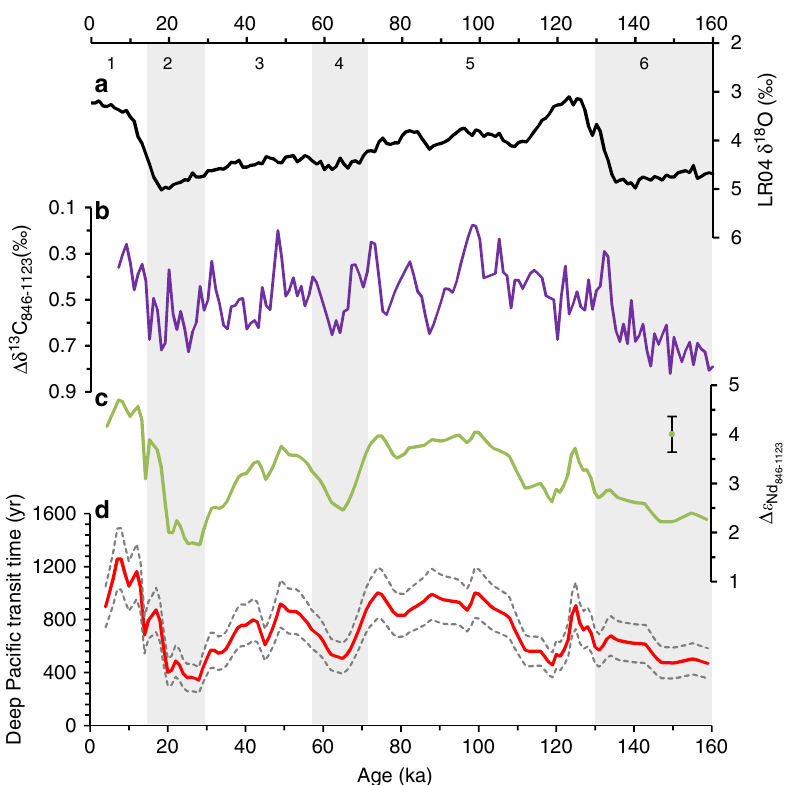
Fig. 7 Deep Paci fi c transit time over the last 160 ka. a Benthic δ 18 O stack 50 . b Benthic δ 13 C gradients between ODP846 and ODP1123. Note that the benthic δ 13 C of ODP846 ( C . wuellerstor fi ) 70 and ODP1123 ( Uvigerina spp.) 8 are measured on different species and vital effects might affect their δ 13 C signatures. c Foraminiferal ε Nd gradients between ODP846 and ODP1123. d The deep Paci fi c transit time estimated from the box model (see parameters in Supplementary Table 10). The grey dash lines display uncertainties propagated from ε Nd measurements (averaged 2 σ for ODP1123 and ODP846 are 0.19 and 0.31, respectively) into the transit time. The grey bars highlight the glacial stages (MIS 2, 4 and